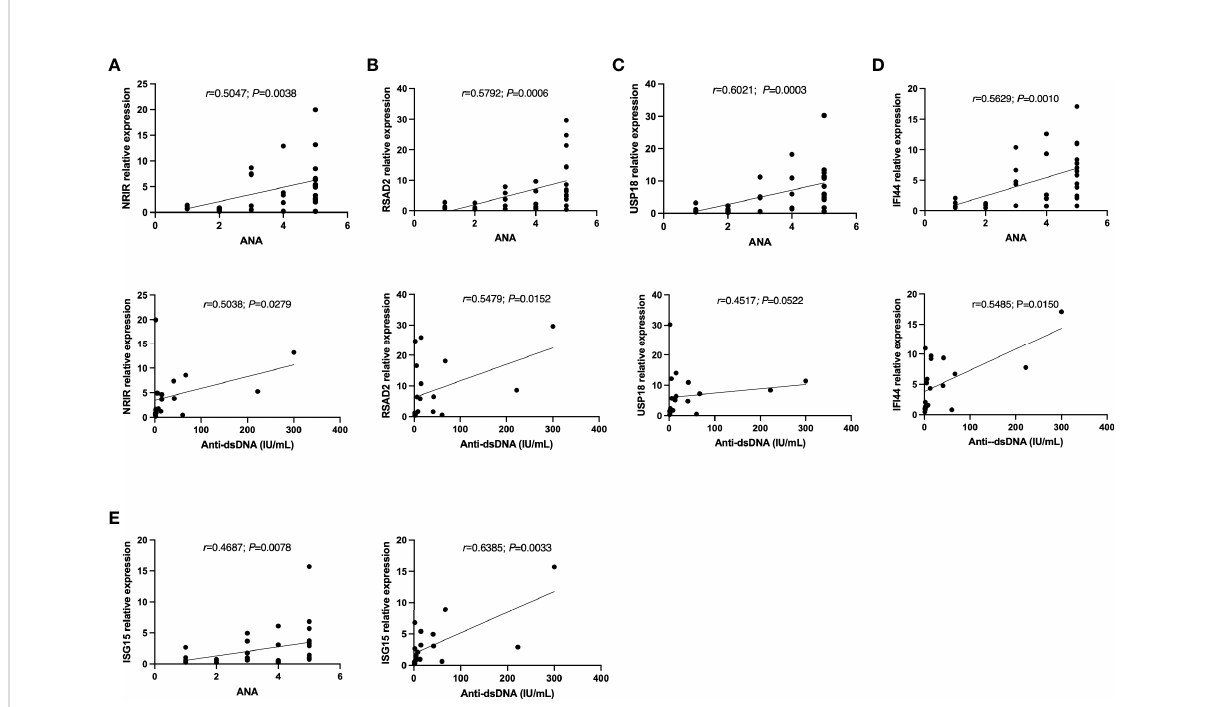
FIGURE 5 The correlations between (A) NRIR, (B) RSAD2, (C) USP18, (D) IFI44, (E) ISG15 relative expression and Autoantibodies levels. Note: ANA: antinuclear antibodies; Anti-dsDNA: anti-double-strand DNA antibody. ANA=1: ANA<55 U/mL; ANA=2: 55 U/mL ≤ ANA-d<100 U/mL; ANA-d=3: